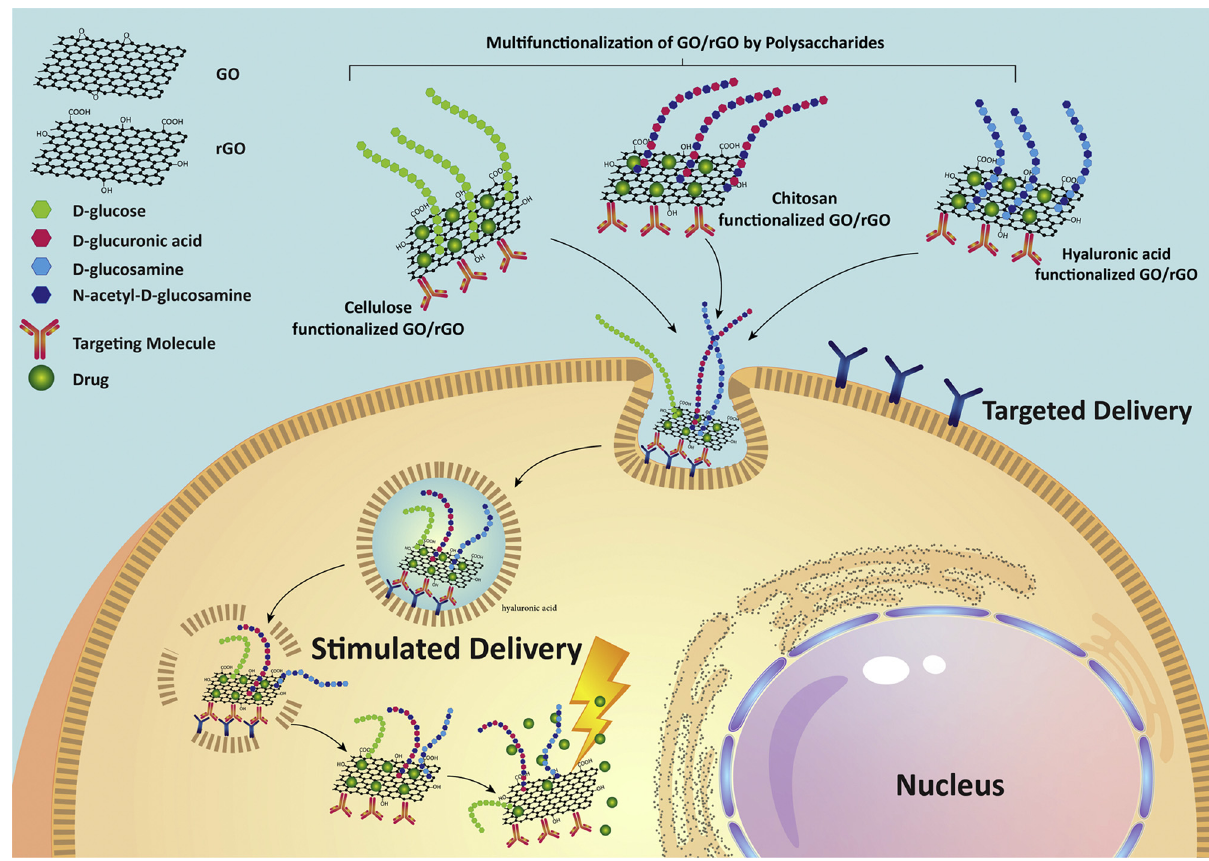
Figure 8: Methods for targeted delivery by graphene - based materials decorated with di ff erent carbohydrate polymers [ 32 ]